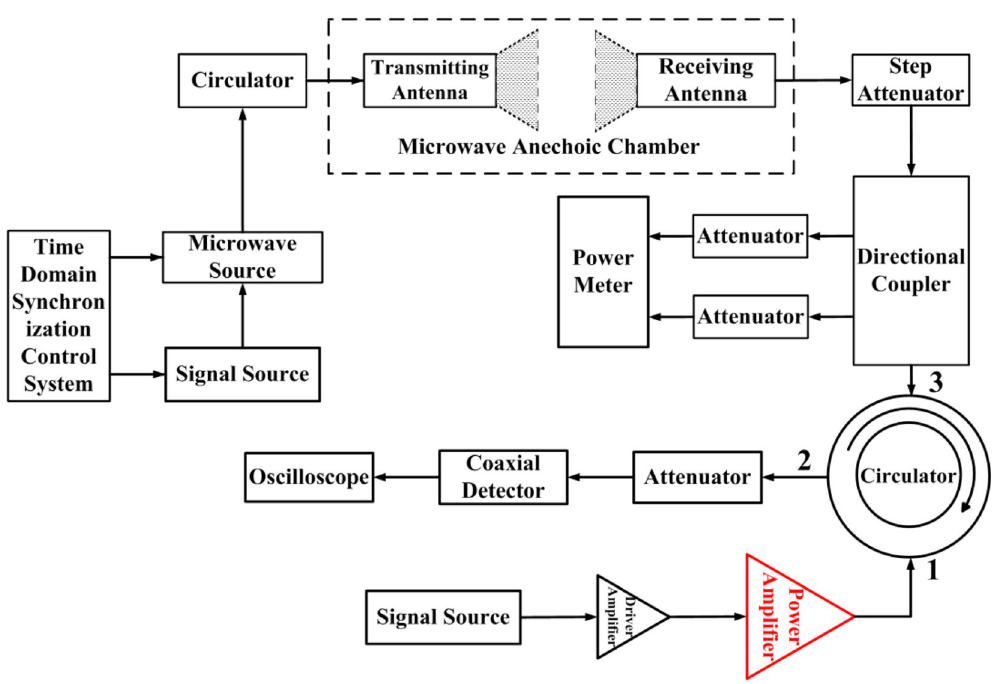
Figure 2. Schematic diagram of the experiment system employed for studying the interference effects in GaN- HEMT power amplifier induced by microwave